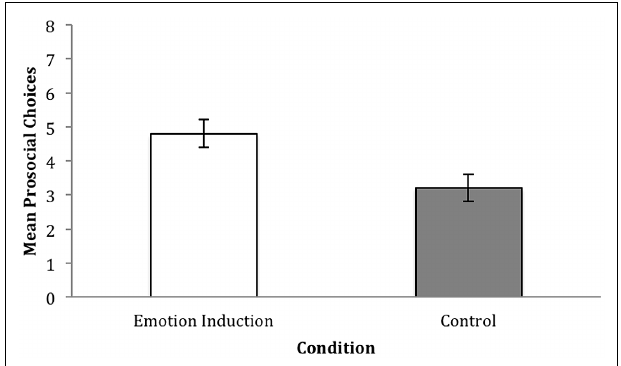
FIGURE 4 | Mean prosocial choices on the resource allocation task with standard error bars, for the emotion induction, and control group, inAI trials in study two (3-year-olds). Scores in cost and no cost trials were pooled into one overall prosocial score, and possible scores ranged from “0” (no prosocial behavior) to “8” (consistent prosocial